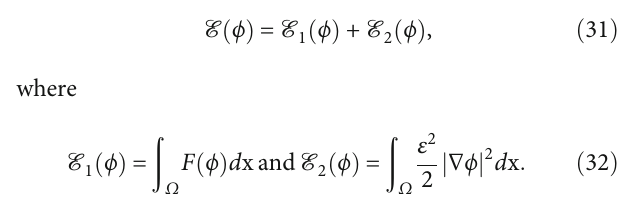
Figure 2: Analytic and numerical growth rates of the CH equation with di ff erent mode numbers at T = 0 : 004 when (a) ϕ ϕ = 0 : 4 and ϕ = 0 : 6 . ave ave